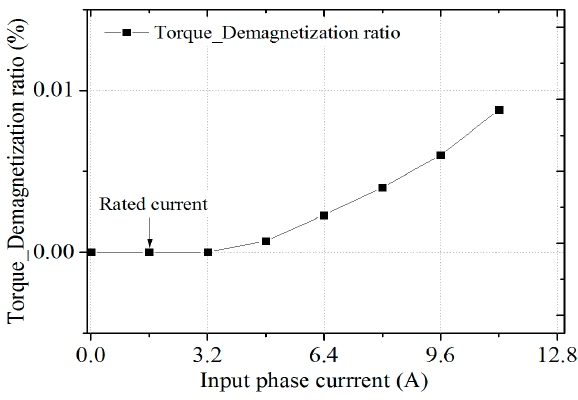
Figure 19. Torque demagnetization ratios of the optimized model.